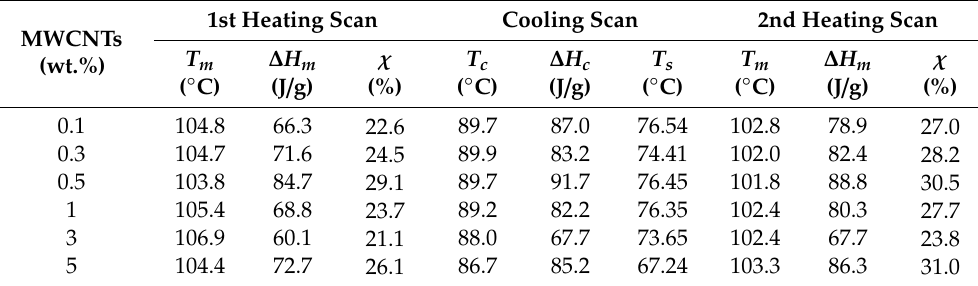
Figure 1. Di ff erential scanning calorimetry (DSC) curves of low-density polyethylene (LDPE) / multi-walled carbon nanotube (MWCNT) composites: ( a ) first cooling and ( b ) second heating at a 10 ◦ C / min rate (the DSC scans are o ff set for clarity). Table 1. The DSC parameters for the LDPE / MWCNT